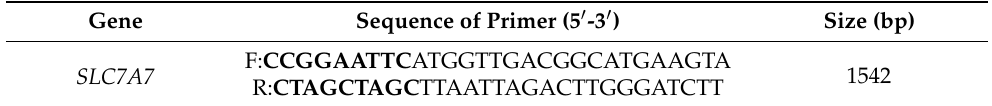
Table 2. SLC7A7 CDS region amplification primer